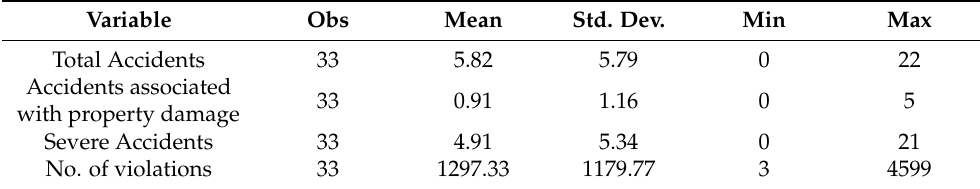
Table 1. 4-leg intersections summary statistics.